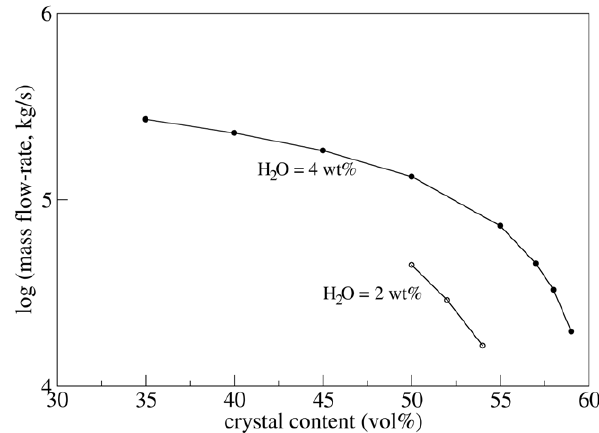
Fig. 6. Calculated pressure distribution along the conduit for mag- mas from 35 to 59vol% of crystals relative to the liquid-crystal phase. Assumed total water content: 4wt%. All other conditions re- ported in Table 3. The calculations are performed with the Conduit4 code (Papale, 2001), assuming a fixed conduit diameter of 4.5m, corresponding to the conduit diameter required (from the simula- tions) to produce an observed mass flow-rate of 2.5 × 10 5 kg/s for the fire-fountain eruption phase with 35vol% crystals.